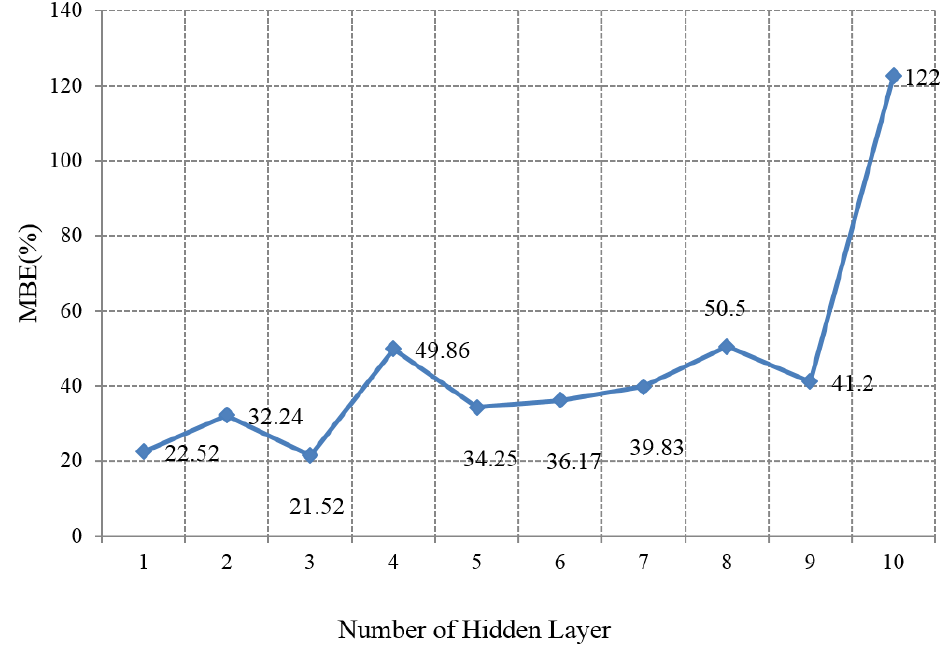
Figure 13. Mean based error (MBE) values by number of hidden layers.